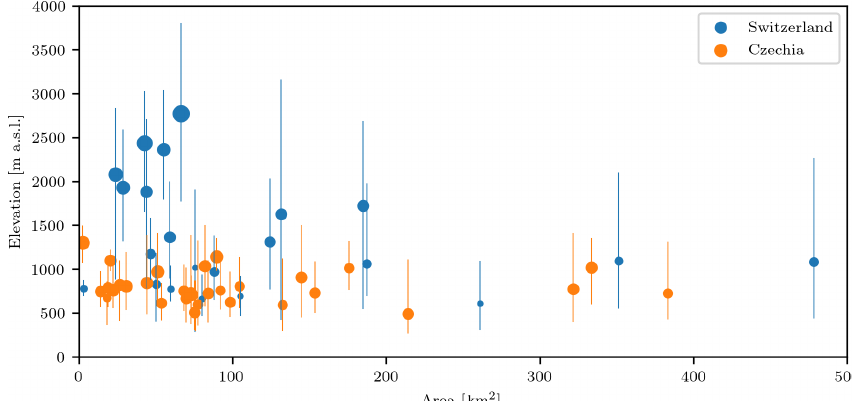
Figure 2. Distribution of the catchments used in this study in terms of area ( x axis), mean elevation and range ( y axis), and relative snowmelt contribution to runoff (ranging form 4% to 62%; indicated by circle size). The catchments are coloured according to their respective geo- graphical domain: blue (Switzerland) and orange